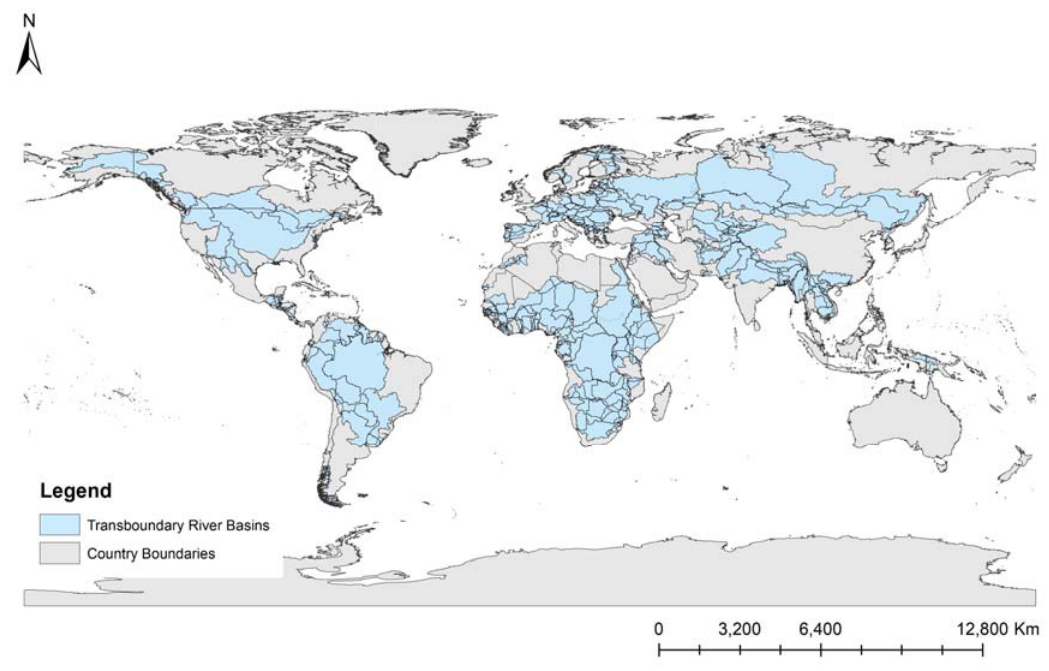
Figure 10. Global Transboundary River Basins (source: Transboundary Freshwater Dispute Database).